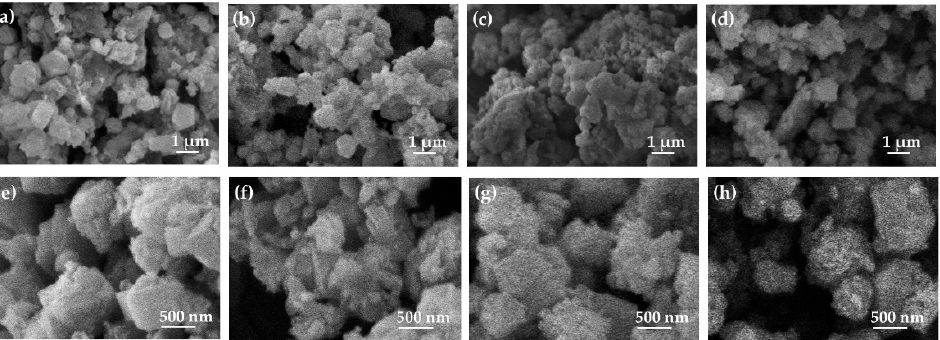
Figure 4. SEM micrographs of powders from initial Na ‐ X 0 zeolites ( a,e ) and zeolites after milling for 60 ( b,f ), 120 ( c,g ), and 540 ( d,h ) seconds at magnifications of 5000 × ( a – d ) and 20,000 × ( e – h ).